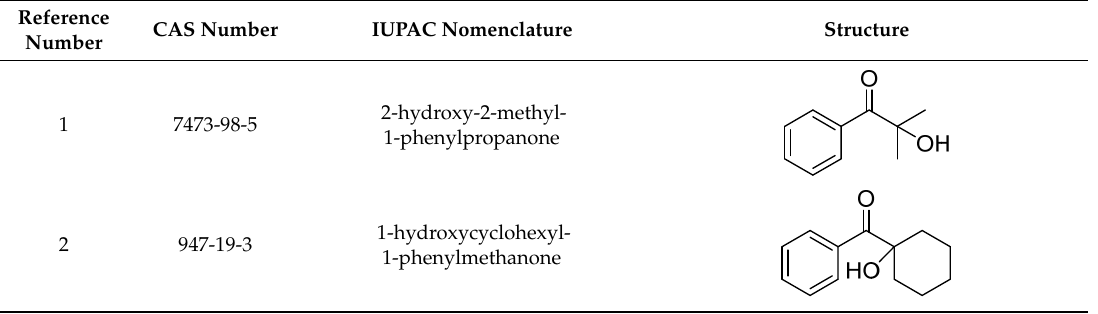
Table 1. Photoinitiator Molecules Analyzed.